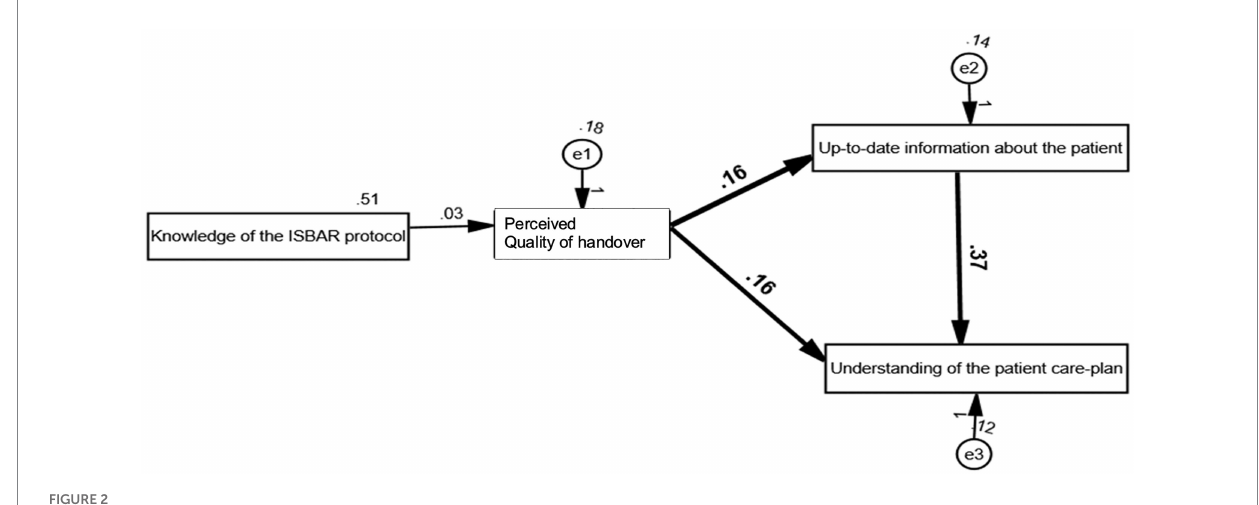
FIGURE 2 Hypothesised model with path coefficients.